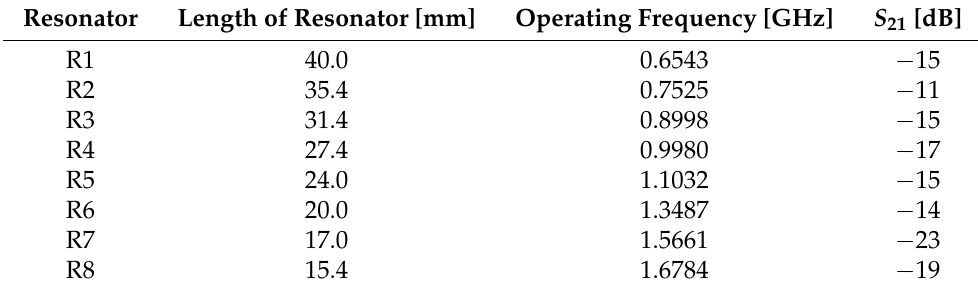
Table 3. Geometrical parameters of 8 bit RFID